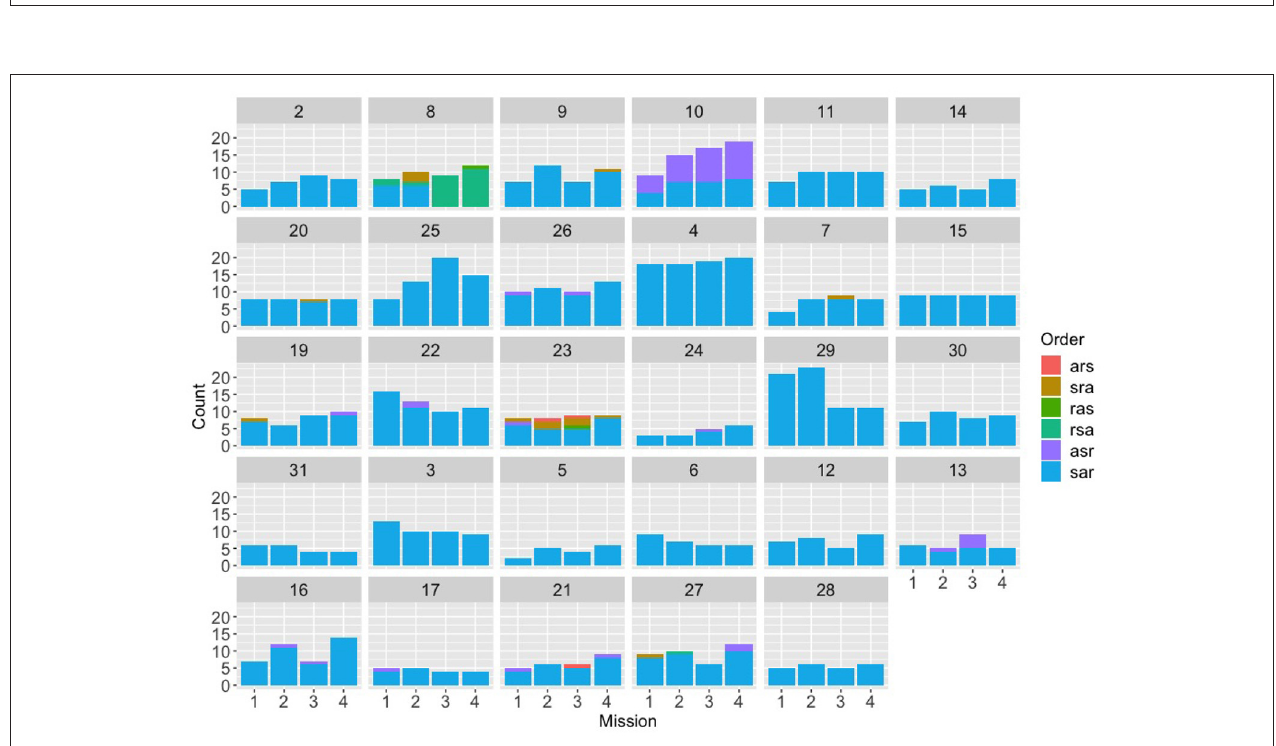
FIGURE 3 | Proportion of “single” communications out of the total of single and multi-communications, across the first four missions from each experiment. Eval refers to the evaluation experiment and its related conditions (control, expert pilot, and synthetic teammate pilot), speech to the speech only experiment, and text to the text experiment.